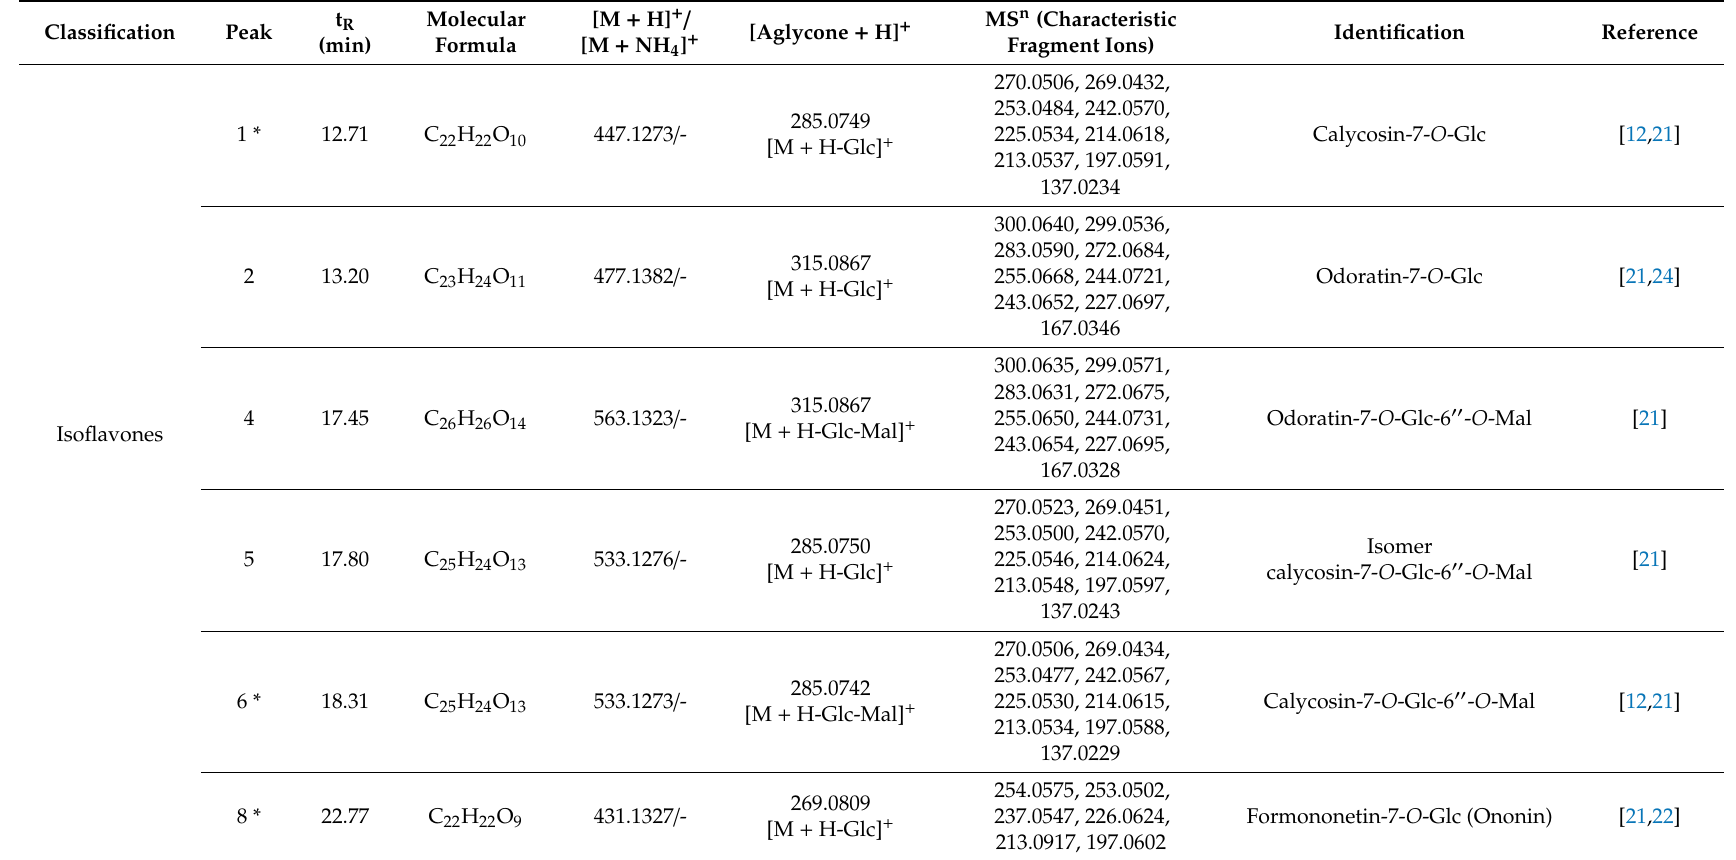
Table 2. MS data for identification of isoflavonoids in Astragali Radix by ( + ) HPLC-Q TOF /